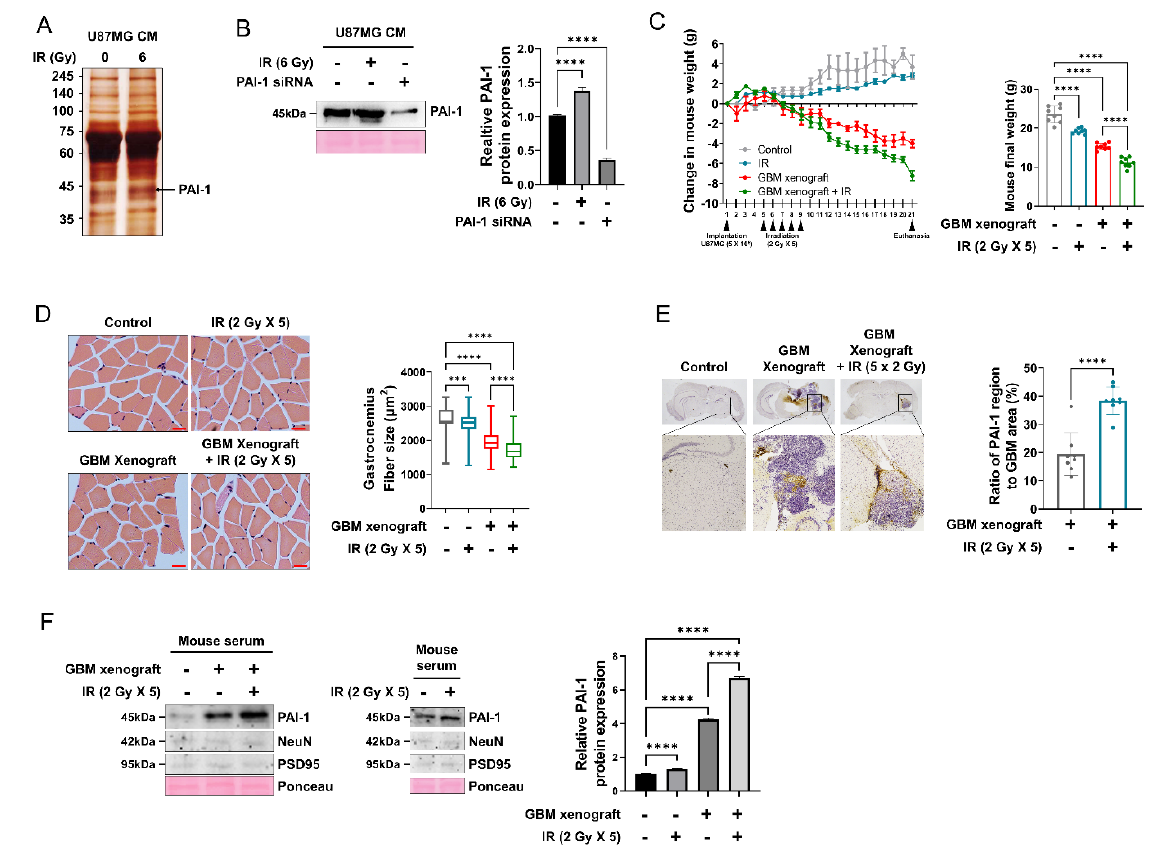
Figure 2. PAI-1 expression and secretion were elevated in irradiated GBM cells and an IR-induced GBM cachexia mouse model. ( A ) The secretome in CM of U87MG cells exposed to 6 Gy was analyzed by silver staining and proteomics using mass spectrometry. The band indicated by an arrowhead corresponds to the PAI-1 protein, which was increased by irradiation. ( B ) Radiation-induced expression levels of the PAI-1 protein in CM of U87MG cells and treated with PAI-1 siRNA were analyzed by western blotting (left panel), and the PAI-1 protein was quantified (right panel). ( C ) Mouse body weight analysis on in vivo in a xenograft mouse model and irradiated xenograft mouse model. Balb/c nude mice were inoculated with 5 × 10 5 U87MG GBM tumor cells and irradiated 2 Gy daily for 5 days (left panel). The final body weights of the mice were analyzed (right panel). ( D ) Mouse skeletal muscles were stained with hematoxylin and eosin (H&E) to demonstrate the extent of the muscle atrophy. The histological changes were assessed in control, IR, GBM xenograft, GBM xenograft, and irradiated mice. Photomicrographs were taken at 20× magnification. Scale bars, 100 μ m. Myofiber cross-sectional area size in gastrocnemius was measured by ImageJ. ( E ) Representative immunohistochemical (IHC) PAI-1 protein staining in mouse brain GBM tumor (left panel). Mouse brain was stained with PAI-1 antibody and DAPI (blue). Scale bar, 100 mm. Occupancy ratio of PAI-1 within the tumor area of GBM xenograft mice (right panel) ( F ) The protein expression of PAI-1, NeuN, and PSD95 in mouse blood serum samples were assessed by western blot (left panel). PAI-1 protein was quantified (right panel). Every in vitro western blot analysis was performed three times. In vivo experiment was performed with 8 mice in each group. Statistical analysis was performed with one-way ANOVA plus Tukey’s multiple comparisons test. *** p < 0.005, **** p <